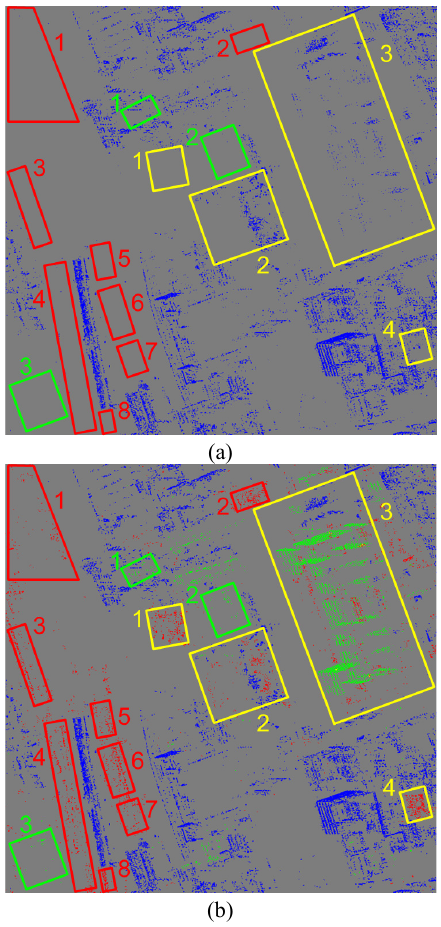
Figure 5. (a) PS points extracted from complete set in experiment. (b) Change detection image. Building change: Red, demolition area; Green, erection area; Yellow, hybrid area. Point type: Blue, PS point; Red, VBC point; Green, EBC point.